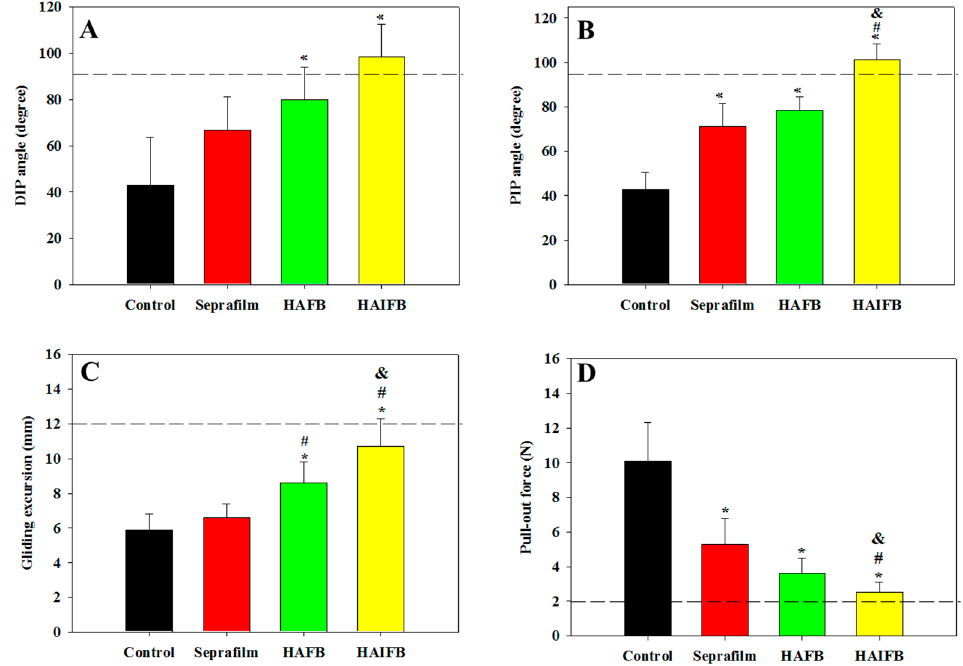
Figure 9. Evaluation of peritendinous adhesions from the distal interphalangeal (DIP) joint flexion angle ( A ), proximal interphalangeal (PIP) joint flexion angle ( B ), tendon gliding excursion ( C ), and pull-out force ( D ) 3 weeks post-operation. The dotted line represents the average value of the normal FDP tendon. * p < 0.05 compared with control, # p < 0.05 compared with Seprafilm ® ; & p < 0.05 compared with HAFB ( n = 6 for each group).